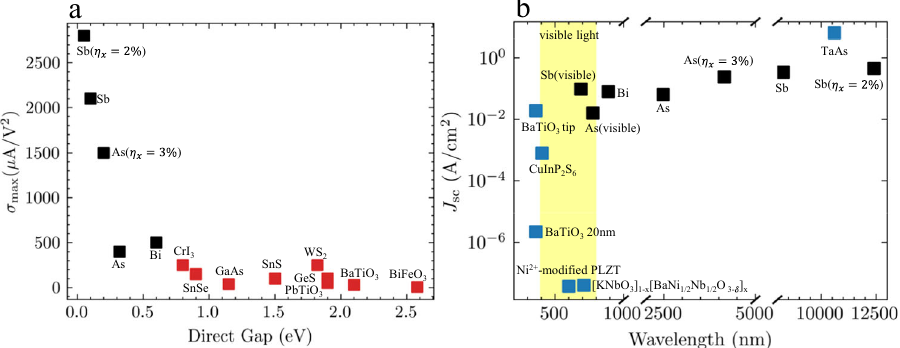
Fig. 11 Comparison of shift current response and current density of different materials. a Peak value of shift current response 29,33,36,59,60 and b current density 4,7,8,10 – 12,15 of different materials assuming a light intensity of 0.1 W/cm 2 . Besides strong band-edge responses to long- wavelength light, monolayer Sb and As can generate large shift currents in response to visible light